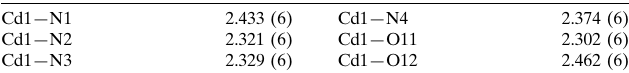
Selected geometric parameters (A˚ , (cid:2) ).